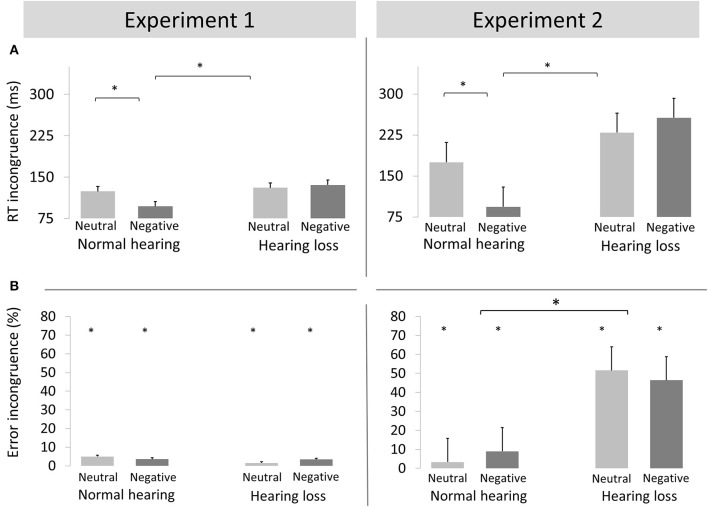
Reaction times (A) and Error rates (B) (mean + standard error of the mean) incongruence effect (incongruent minus congruent) for neutral and negative conditions of Experiment 1 (left) and Experiment 2 (right) for adults with normal hearing and with hearing loss. *p < 0.05.